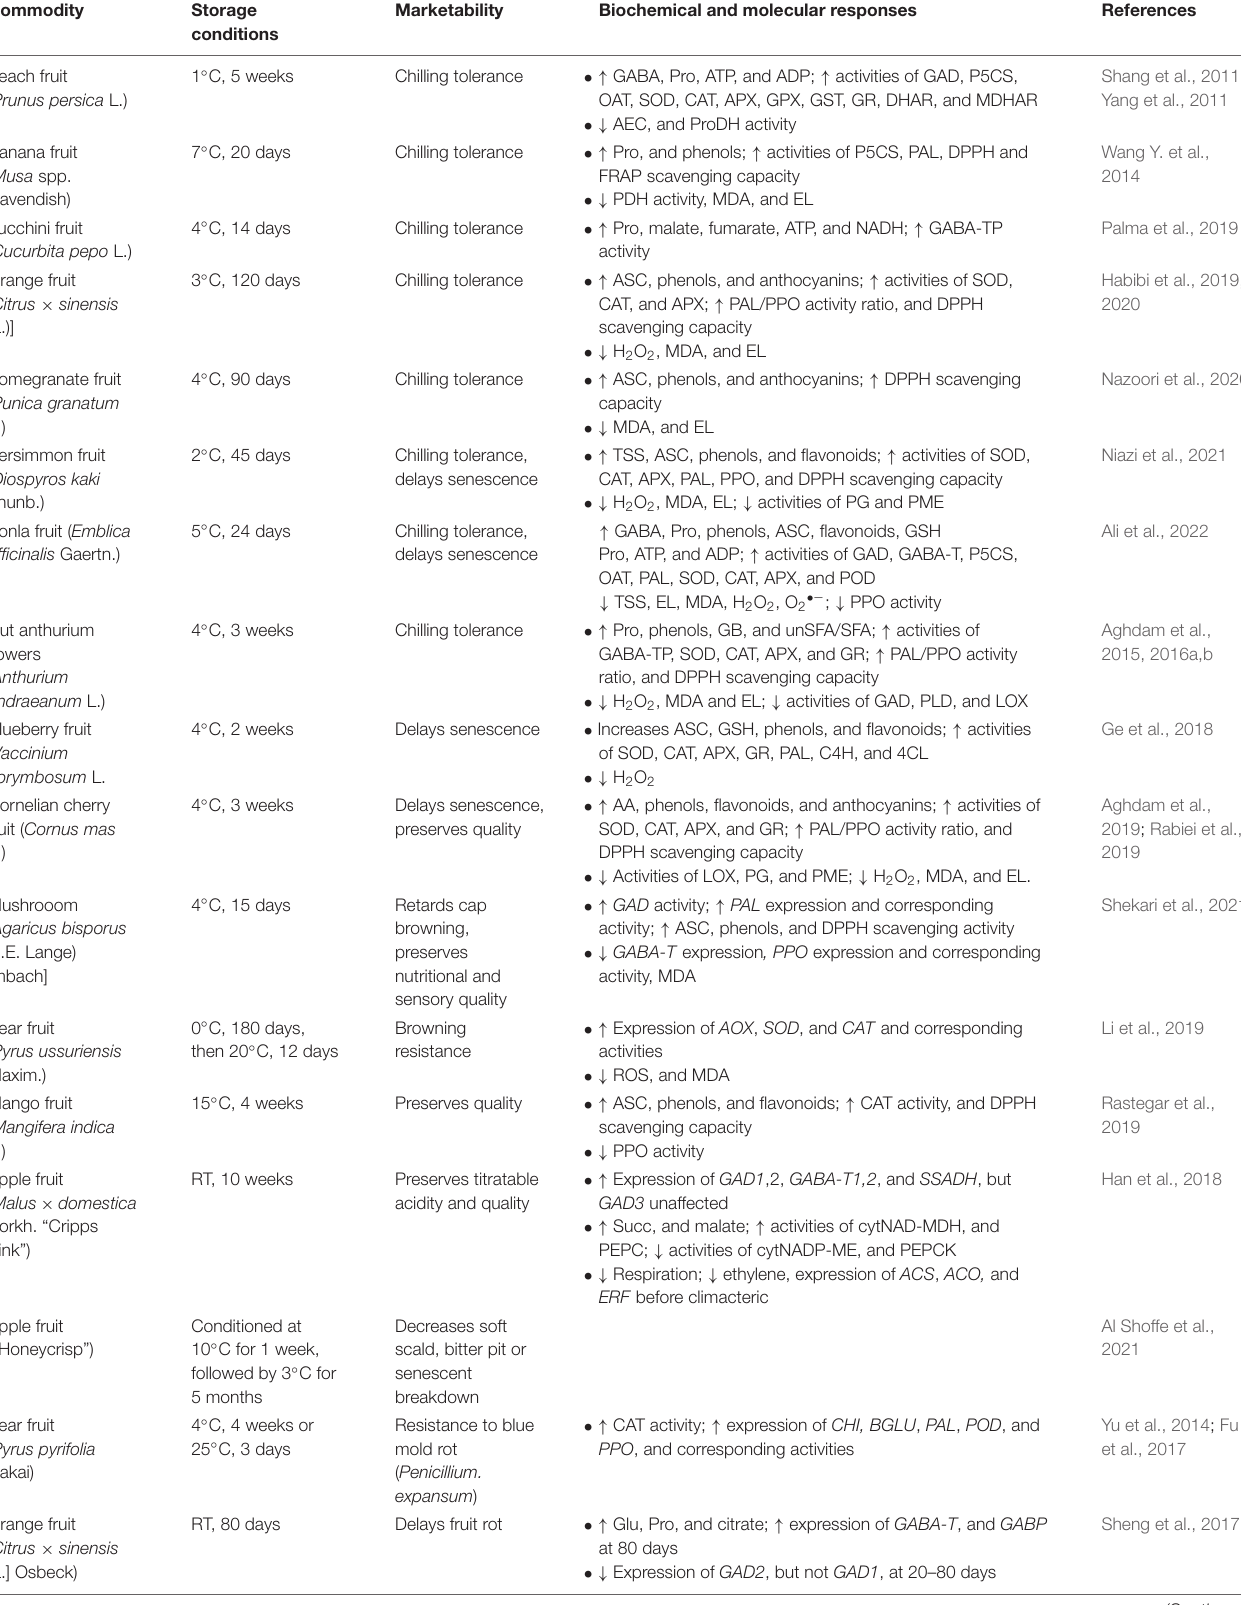
TABLE 3 | The application of exogenous GABA improves the postharvest marketability of horticultural commodities by promoting GABA and antioxidant